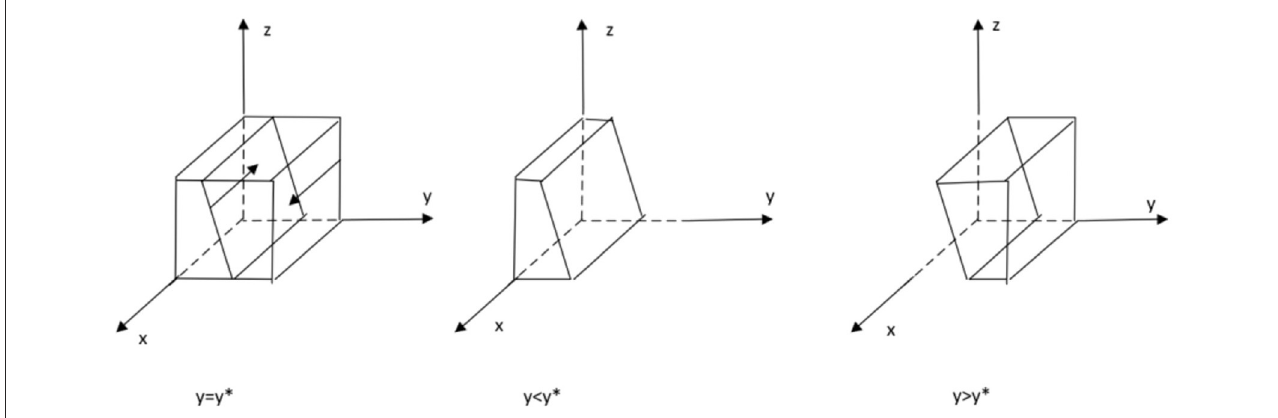
FIGURE1 Phase diagram of the evolution of private sector strategies.